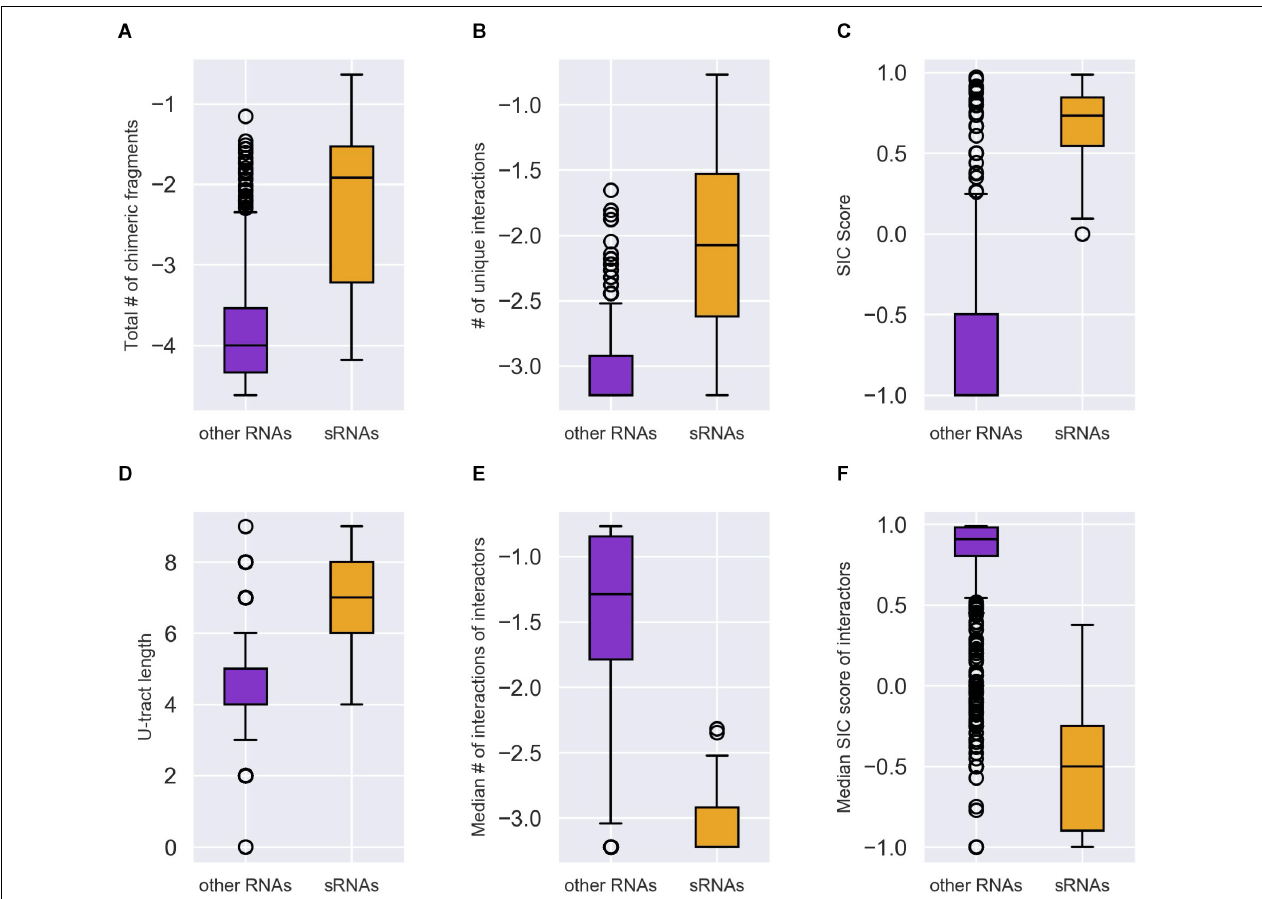
FIGURE 2 | Distinction between sRNAs and “other RNAs” by the characteristic features. Each RNA was characterized by the following features: (A) Total number of the chimeric fragments the RNA is involved in. This value was normalized by the total number of chimeric fragments in the data set and then transformed to Log 10 scale. (B) Number of unique interactions the RNA is involved in. This value was normalized by the total number of interactions in the data set and then transformed to Log 10 scale. (C) SIC score (SIC, for Second-In-Chimera), namely the percentage of chimeric fragments in which the RNA was second in the chimera, penalized by the number of unique interactions the RNA is involved in. (D) The U-tract length of the RNA. (E) The median number of interacting partners of the RNA interactors (normalized as in B and expressed by Log 10 ). (F) The median SIC score of the RNA interactors. The distributions of each feature values in the group of known sRNAs (orange) and “other RNAs” (purple) are described by boxplots. The differences between the two distributions (A–F) were found to be statistically significant by two-tailed Mann–Whitney U test ( p values between 10 - 23 and 10 - 11 after Bonferroni correction for multiple hypotheses testing). The distributions in panels (A–F) are based on the data of stationary phase RIL-seq experiment ( Supplementary Table 1 ). Results for the exponential phase data sets are shown in Supplementary Figures 2 , 3